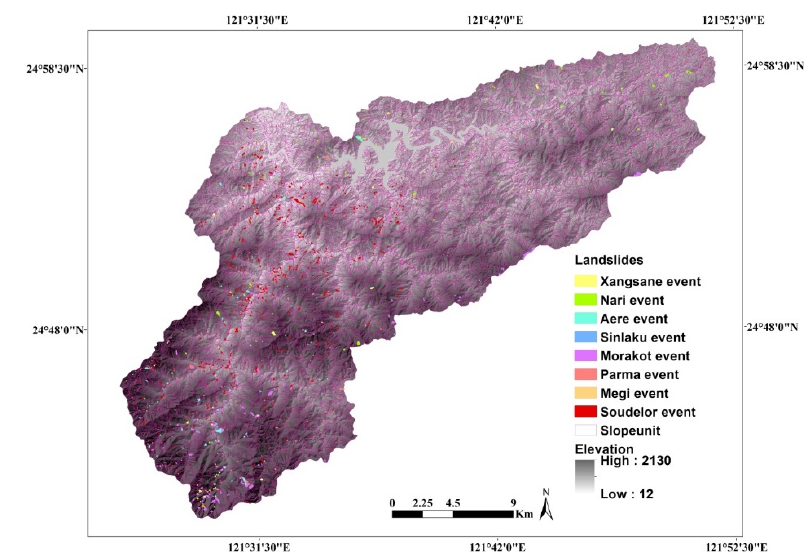
Figure 4. Distribution of slope units and landslide sites caused by the eight typhoon events in the